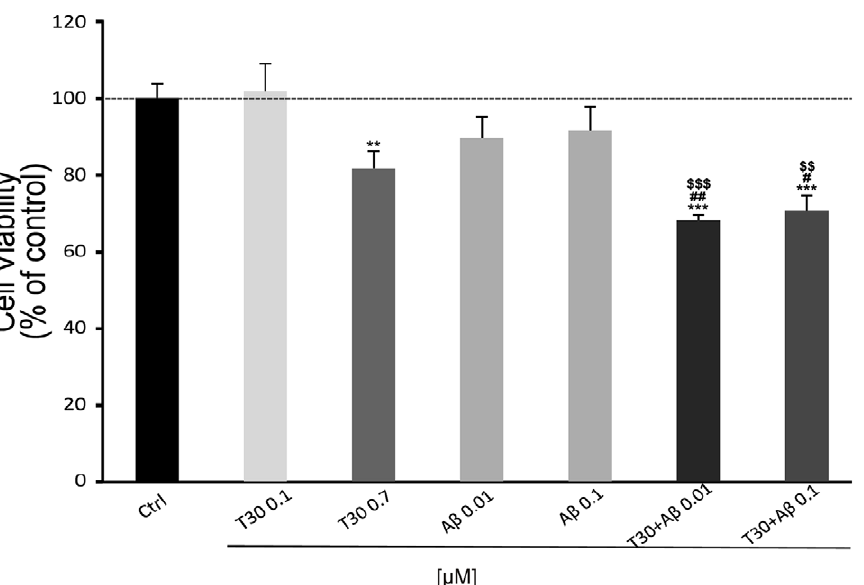
Figure 5. Bar graph showing the additive effect of b -Amyloid (A b ) and AChE C-terminus peptides of 30 amino acids (T30) on cell viability. Cells were treated for 1 hour. Data is presented as % cell viability 6 SEM (N=3). * vs Control: ** P , 0.01, ** P , 0.001; # vs T30: ## P , 0.01, ### P , 0.001; & vs A b : & P , 0.05, && P , 0.01.